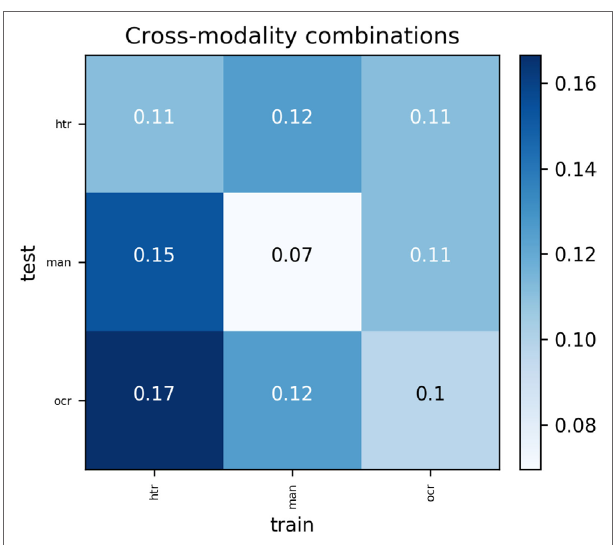
FigUre 10 | Outcome of the cross-modality experiments, presented as a square matrix showing misclassifications (error rate).